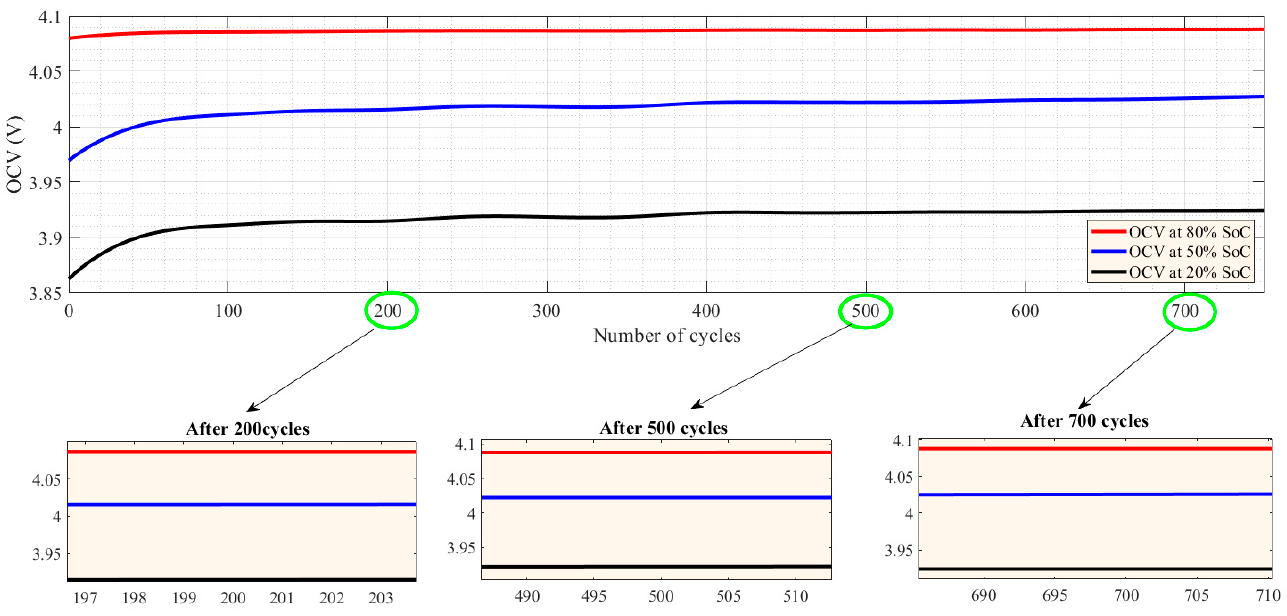
Figure 11. Comparison of the OCV pattern at 25 °C under C/2 charge and 2 C discharge test conditions.